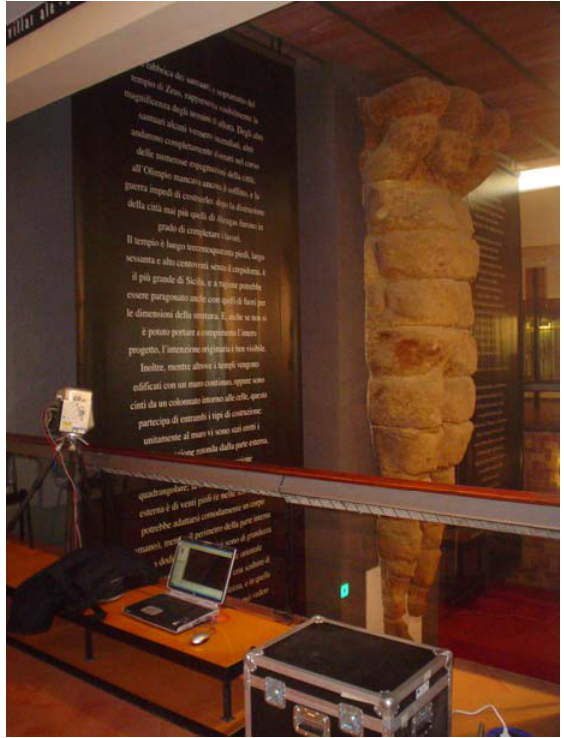
Figure 4. Laser scanning data acquisition